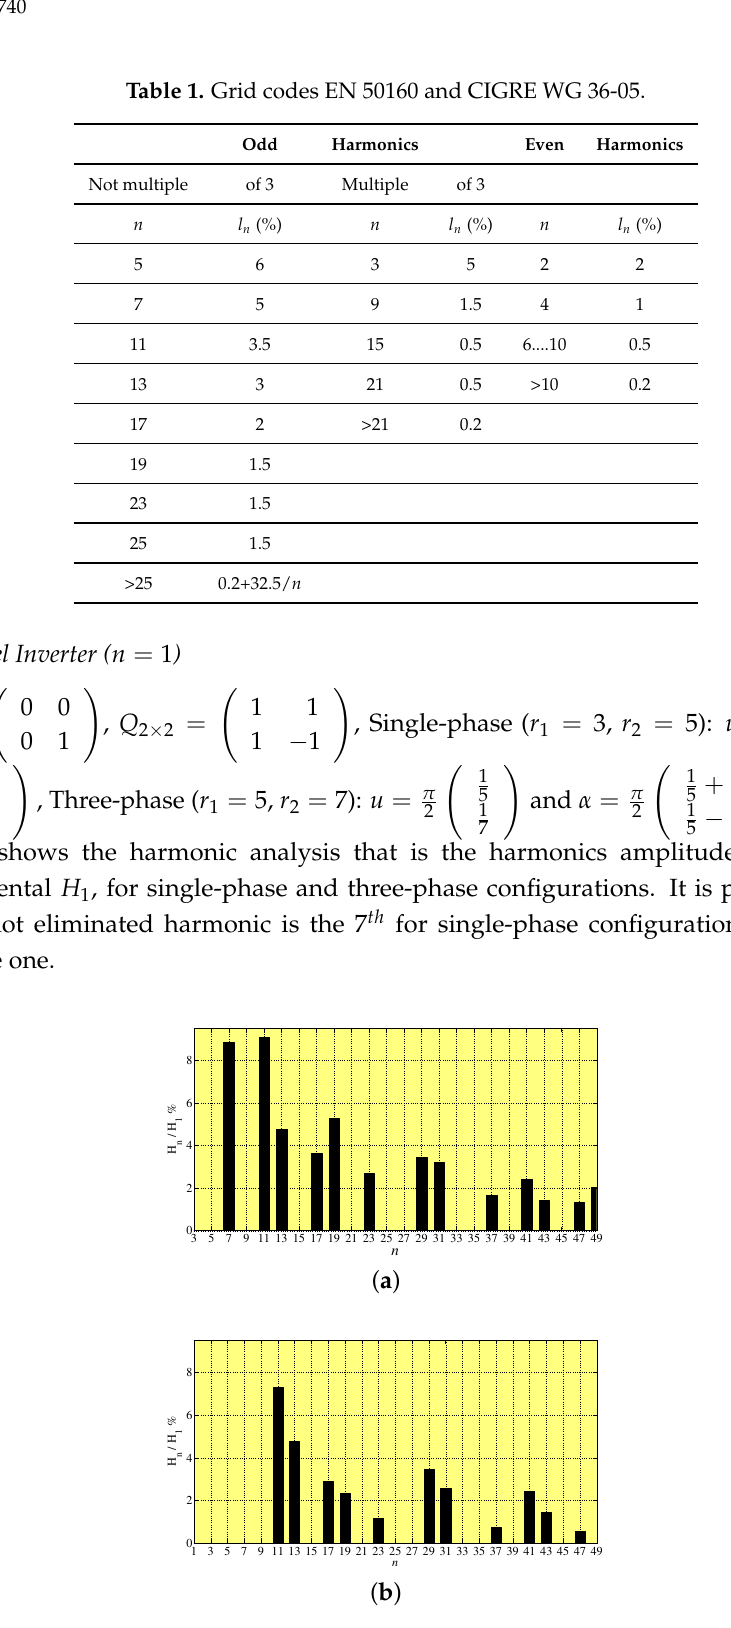
Figure 5. Percentage values of harmonics amplitudes H n with respect to the fundamental H 1 for the CHB 5-level inverter: ( a ) single-phase configuration, ( b ) three-phase